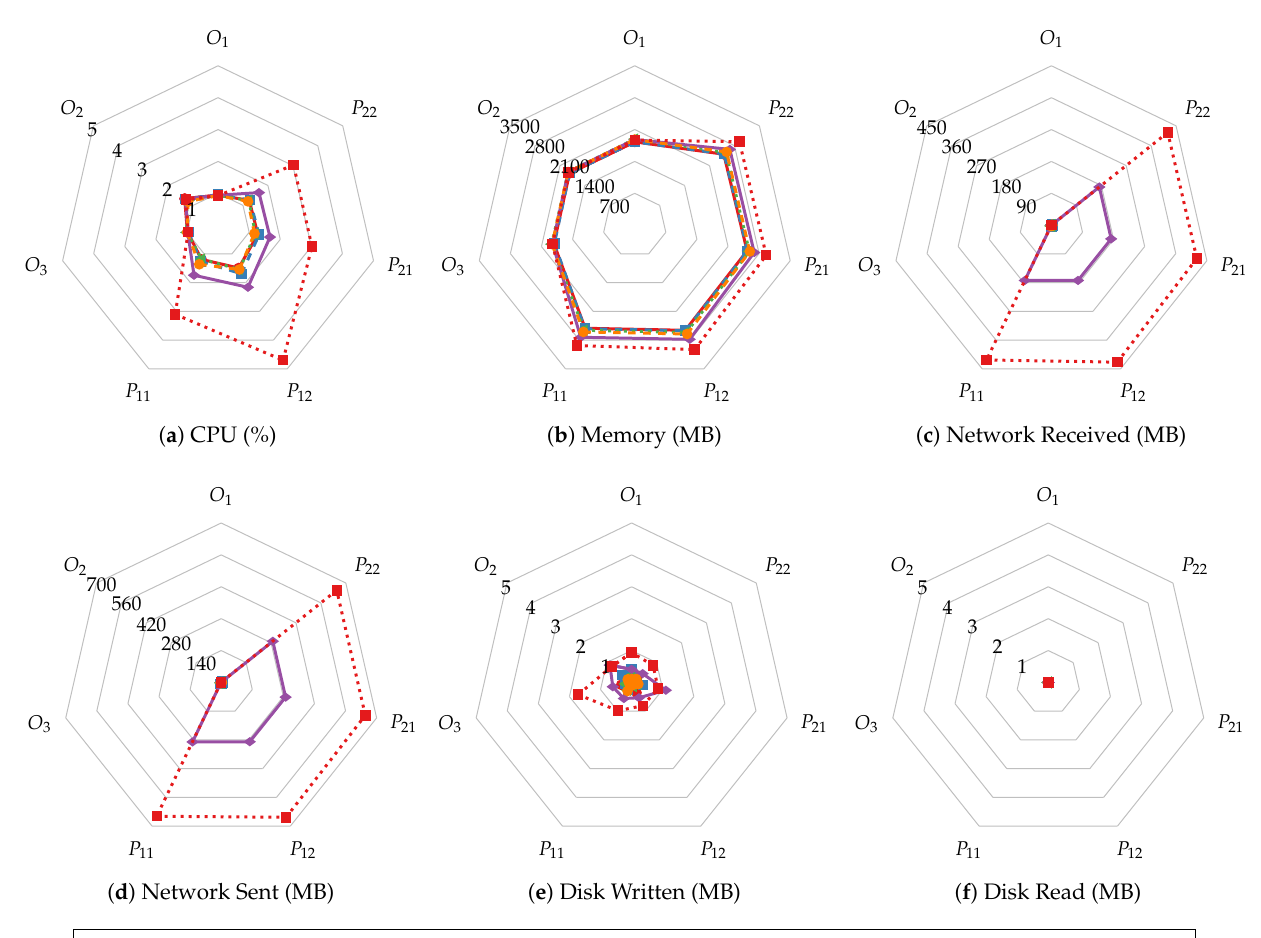
Figure 11. The average CPU usage ( a ), average memory usage ( b ), total data received from the network ( c ) and sent to the network ( d ), total data written to disk ( e ) and read from disk ( f ) of orderer1 ( O 1 ), orderer2 ( O 2 ), orderer3 ( O 3 ), org1 peer1 ( P 11 ), org1 peer2 ( P 12 ), org2 peer1 ( P 21 ), and org2 peer2 ( P 22 ) during read operations when S soft = 2